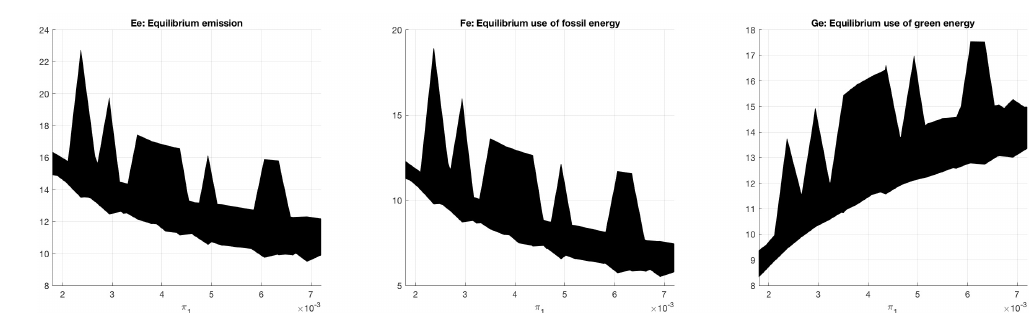
Figure A7. e , f and g for OECD